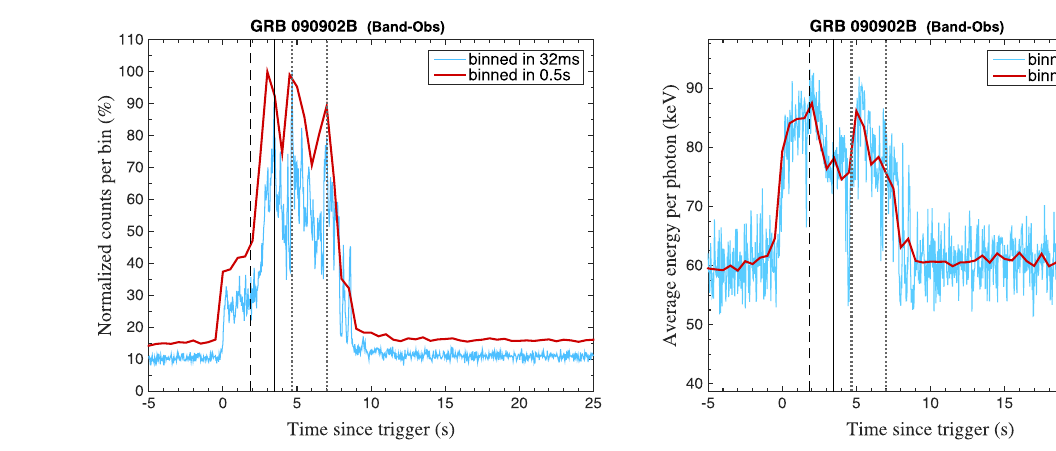
refer to t obs /( 1 + z ) of Criterion 2 (the significant peak of the average energy curve). The dotted lines refer to the other peaks in the light curve